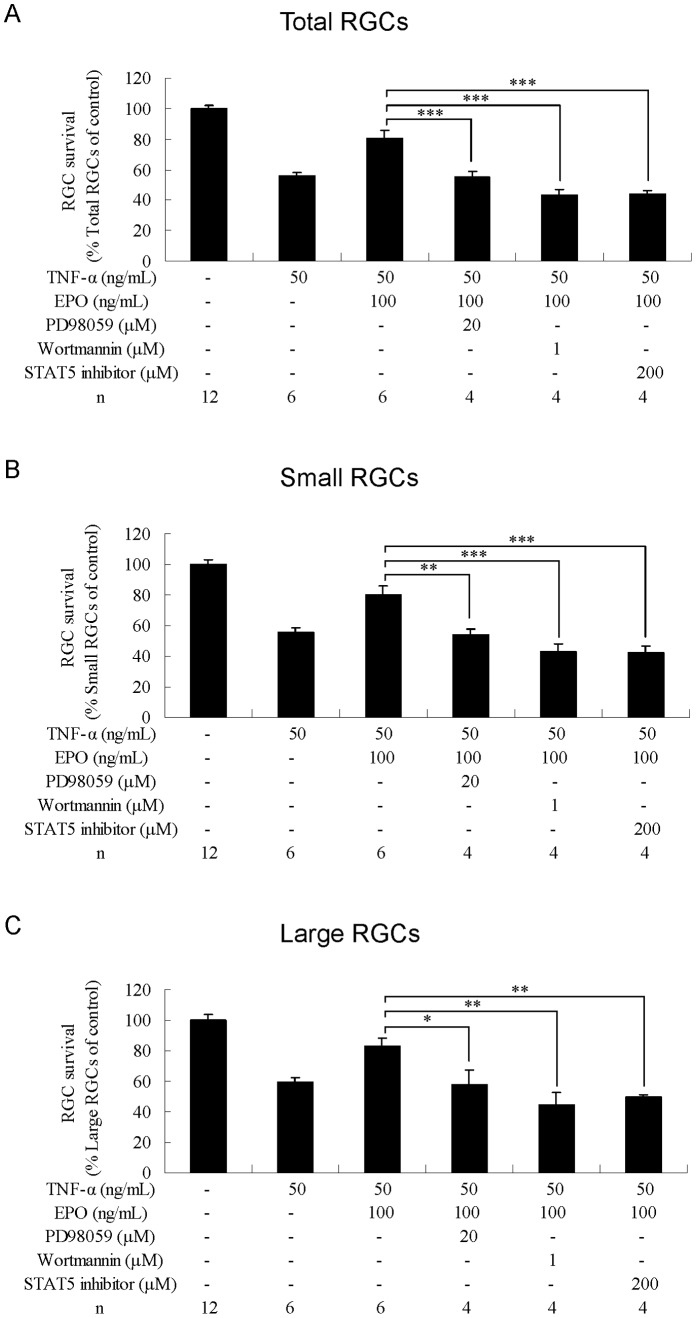
Effects of combined treatment with erythropoietin and kinase inhibitors on RGCs under TNF-α-induced toxicity.Survival rates of (A) total, (B) small, and (C) large RGCs were estimated as percentages of the control. Data are presented as mean ± standard error of the mean (n = 6–12). Data were statistically analyzed by 1-way ANOVA, followed by the Dunnett’s test. *P<0.05, **P<0.01 and ***P<0.001.